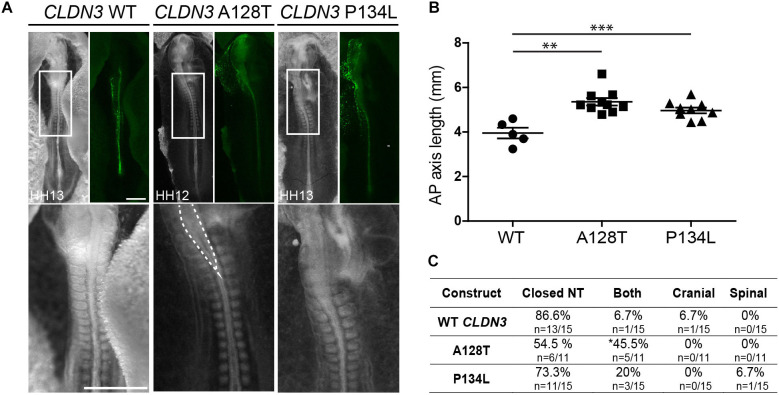
Embryos overexpressing CLDN3 A128T exhibit open NTDs. (A) Dorsal view of chick embryos electroporated with wild-type (WT) or variant Cldn3-IRES-GFP constructs. Brightfield images are shown on the left and GFP expression on the right. High magnification images of the boxed region are shown in the bottom row. Dashed lines outline the open neural tube of an embryo overexpressing CLDN3 A128T. Scale bar, 500 μm. (B) Graph shows anterior–posterior (AP) length of embryos electroporated with wild-type CLDN3, CLDN3 A128T and CLDN3 P134L at the neural tube stage (mean ± s.e.m., **p < 0.005, ***p < 0.0005, Mann–Whitney U-test). (C) Table showing the distribution of complete, cranial and caudal open NTDs observed in embryos overexpressing wild-type CLDN3, CLDN3 A128T or CLDN3 P134L (*p < 0.05, Chi-square test).